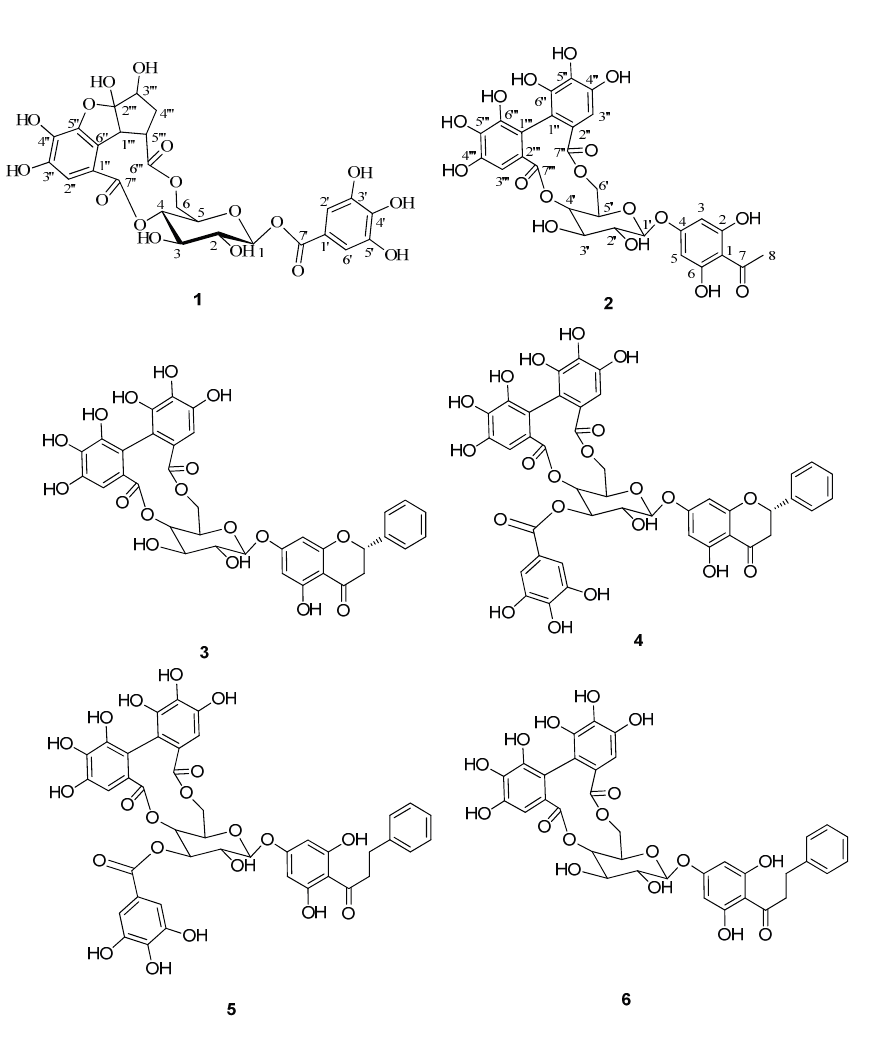
Figure 1. Compounds 1 – 6 isolated from Penthourm